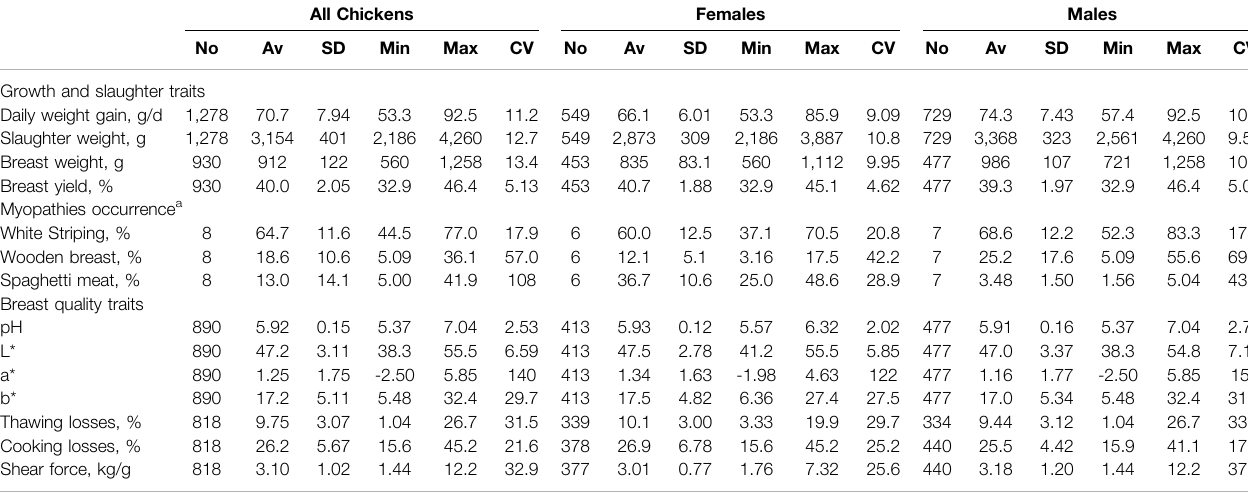
TABLE 2 | Descriptive statistics of growth traits, slaughter traits, myopathy occurrence and meat quality of pectoralis major in broiler chickens: data collected over eight experimental trials. All Chickens Females